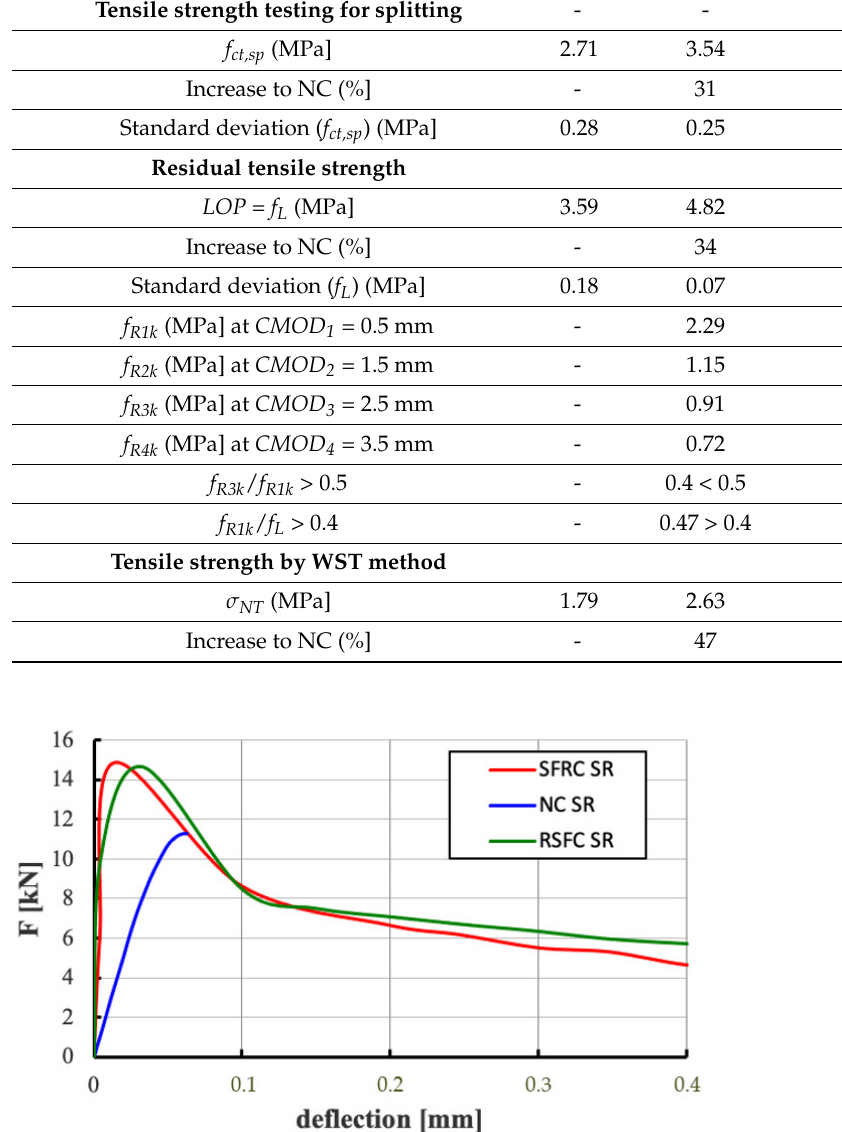
Table 5. Comparison of tensile strength for concretes without fibres (NC) and with fibres (SFRC and RSFRC).